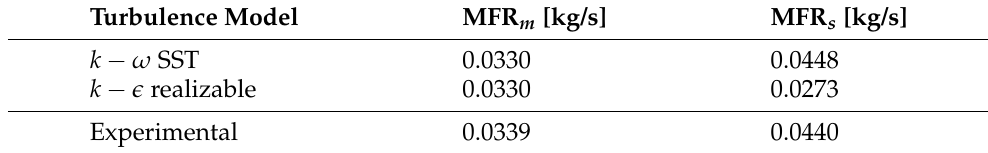
Table 5. Comparison of turbulence the k − ω SST and k − (cid:101) realizable models for Case I with mesh D. Turbulence